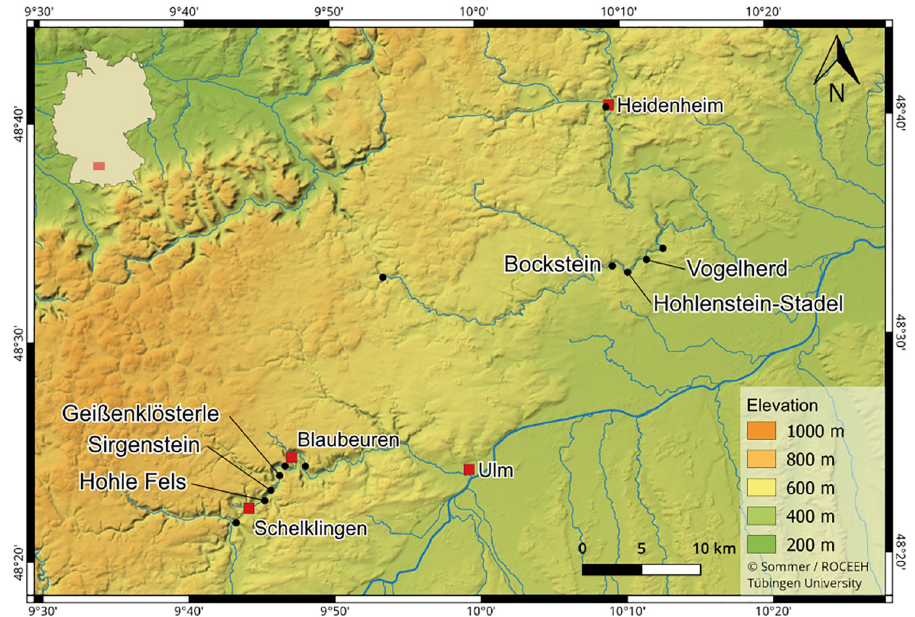
Fig 1. Map of the studied sites. Map of sites included in this study. https://doi.org/10.5281/zenodo.3460300 (CC BY 4.0